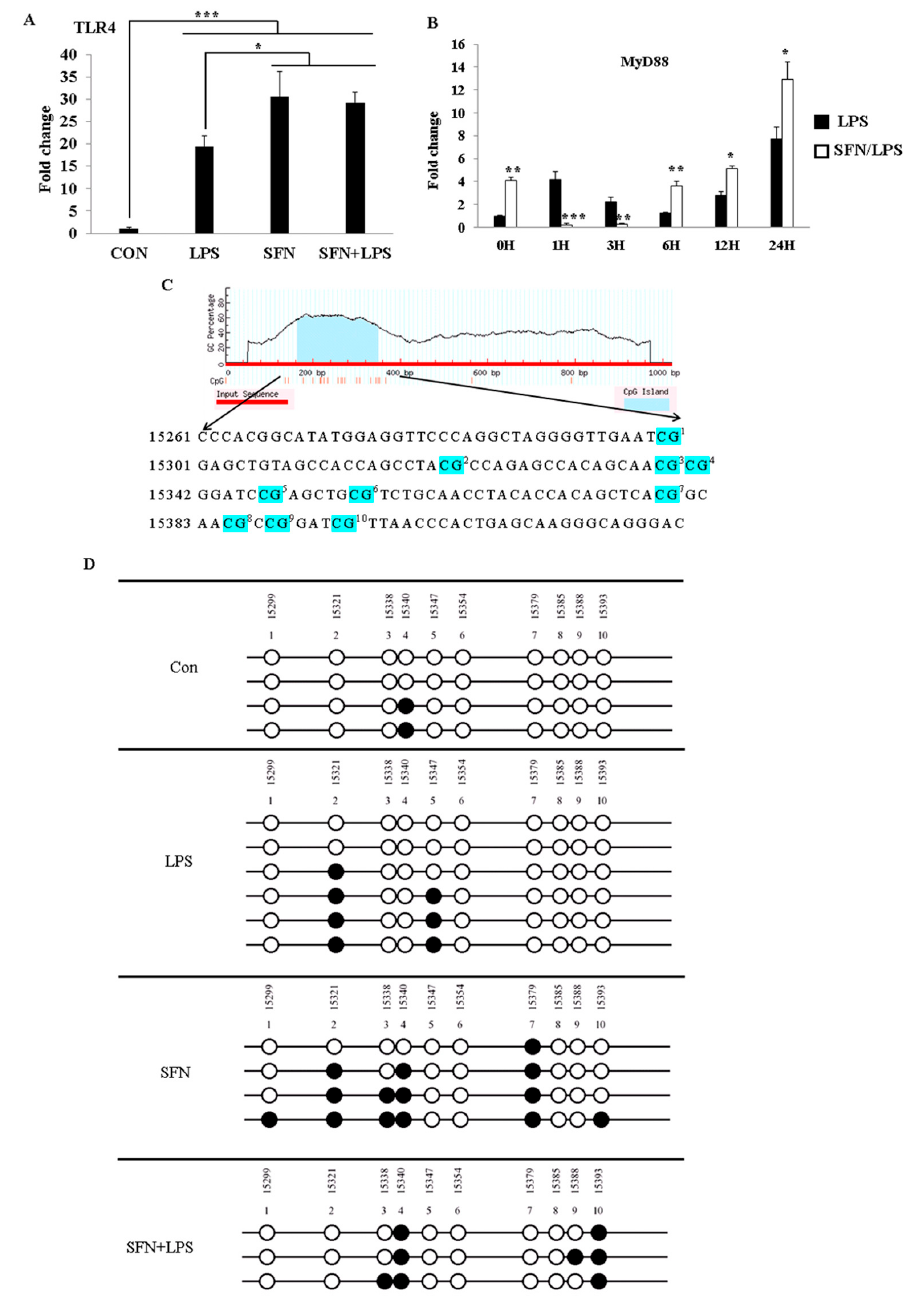
Figure 2. SFN pre-treatment followed by LPS stimulation suppressed DNA methylation of the Toll-like receptor 4 (TLR4) gene. The effects of SFN 10 ( µ M) on TLR4 and MyD88 gene expression in response to LPS (1 µ g/mL) were quantified using qRT-PCR at the indicated time points in moDCs. The moDCs, cultured for 7 days, were pre-incubated with or without SFN and were stimulated with LPS for 0, 1, 3, 6, 12, and 24 h. The TLR4 gene expression was measured at 24 h post-LPS stimulation with or without SFN pre-incubation ( A ). MyD88 mRNA expression was quantified at 0, 1, 3, 6, 12, and 24 h ( B ). The results were combined from three independent experiments, and each experiment was performed in triplicate. The data are represented as the mean ± standard deviations (SD) (* p < 0.05; ** p < 0.01; *** p < 0.001). Ten CpG motifs around the gene body of TLR4 were predicted using the MethPrimer online program ( C ). The DNA methylation status within the CpG island was quantified using bisulfite sequencing PCR ( D ). A minimum of four positive clones were randomly picked for sequencing with M13 primers. The sequencing results were visualized using QUMA software. White plots correspond to unmethylated CpGs, and black plots correspond to methylated